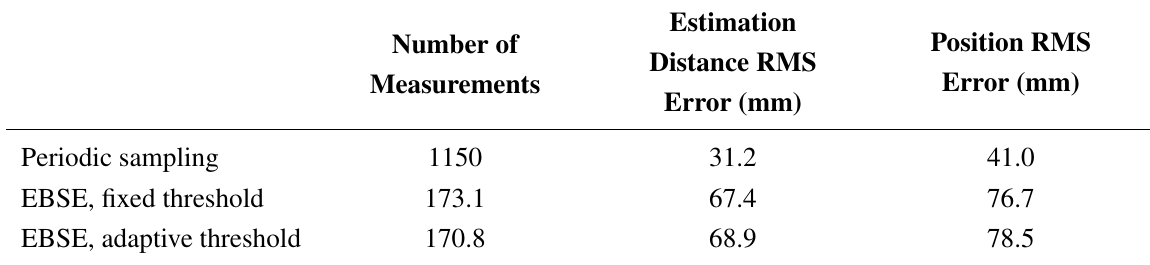
Table 1. Numerical results during tracking time (average results of 20 simulations).